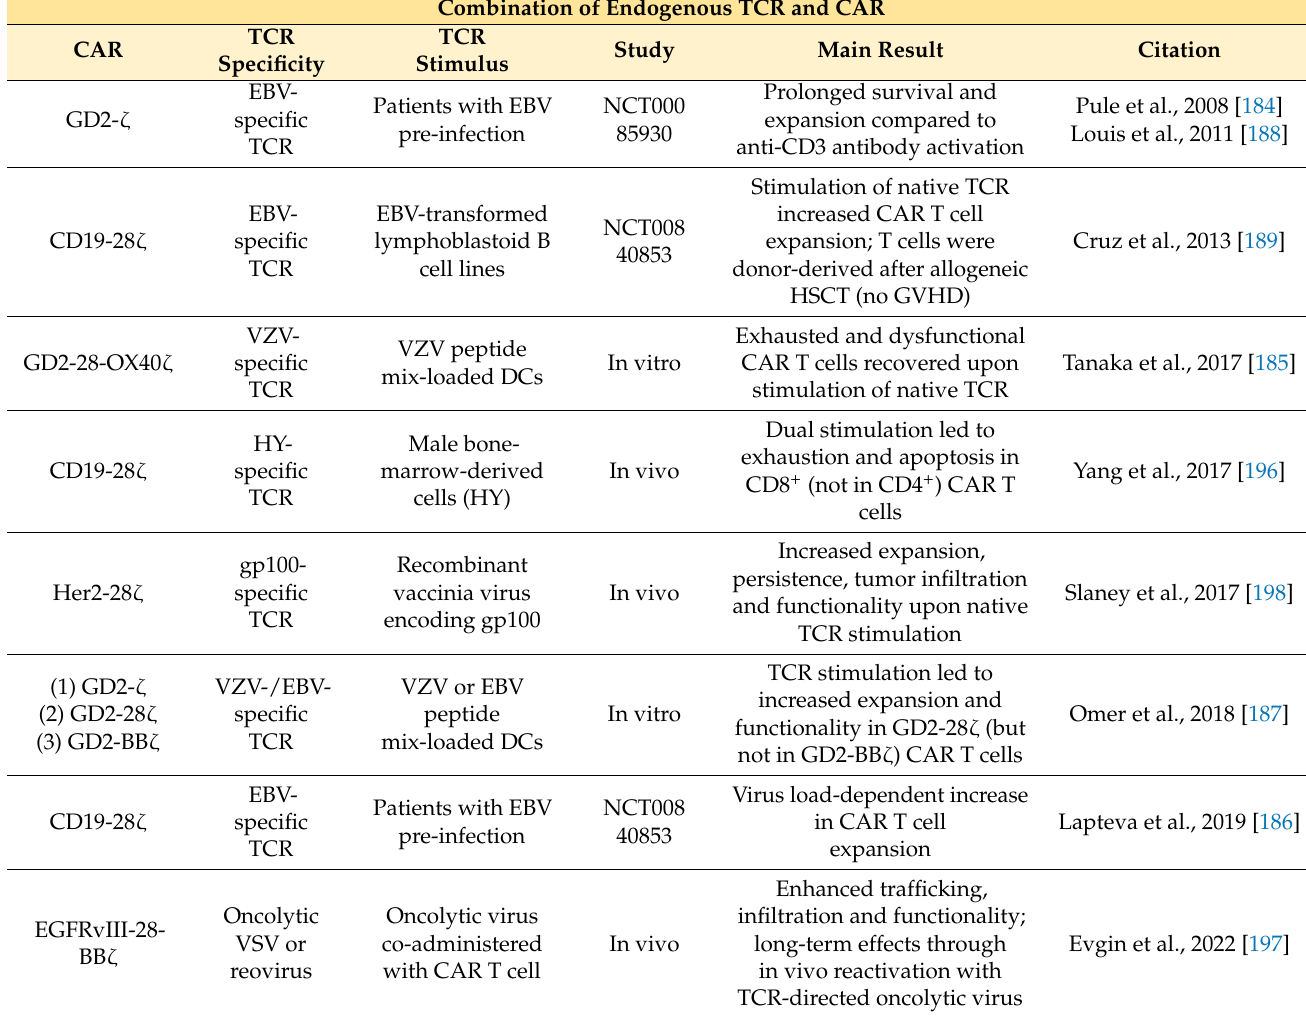
Table 2. Overview of studies combining endogenous TCR and